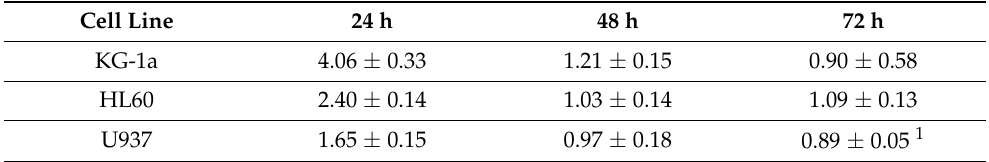
Figure 1. Thioalkaloid-enriched fraction from the N. lutea leaf extract (NUP) induces growth inhibition and cytotoxicity in AML cell cultures. KG-1a HL60 and U937 cells (1.5 × 10 5 cells/mL) were incubated with vehicle or NUP at the indicated concentrations for 24–72 h, followed by the Trypan Blue exclusion assay. ( a – c ) Changes in the total (viable plus dead) cell numbers; ( d – f ) changes in the viable cell numbers; ( g – i ) changes in the percentage of dead cells. The data are means ± SD of at least 3 independent experiments performed in triplicate. Table 1. Comparison of the cytotoxic potency of NUP in KG-1a, HL60, and U937 human AML cell lines at different time points (IC 50 values).